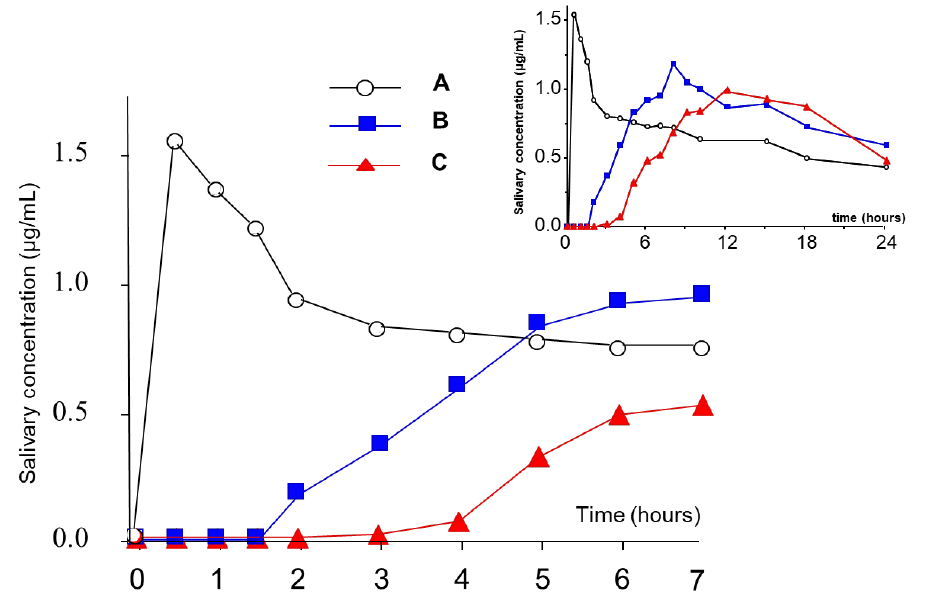
Figure 20. Release profiles of a tracer substance from uncoated tablets and systems spray-coated with Methocel ® E50 to increasing weight gains. Adapted with permission from Ref. [58]. 2009, John Wiley & Sons.